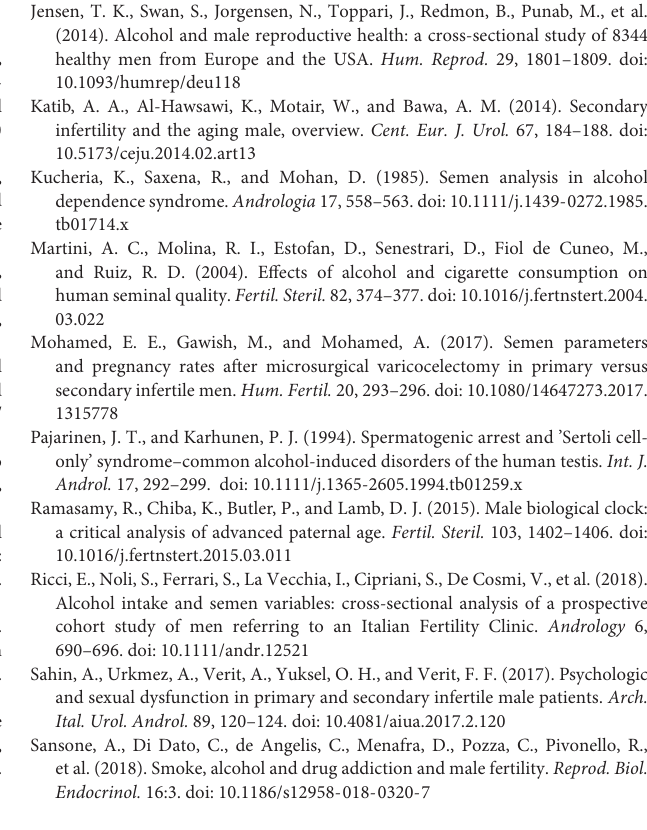
TABLE S1 | Intragroup correlation for semen parameters and alcohol